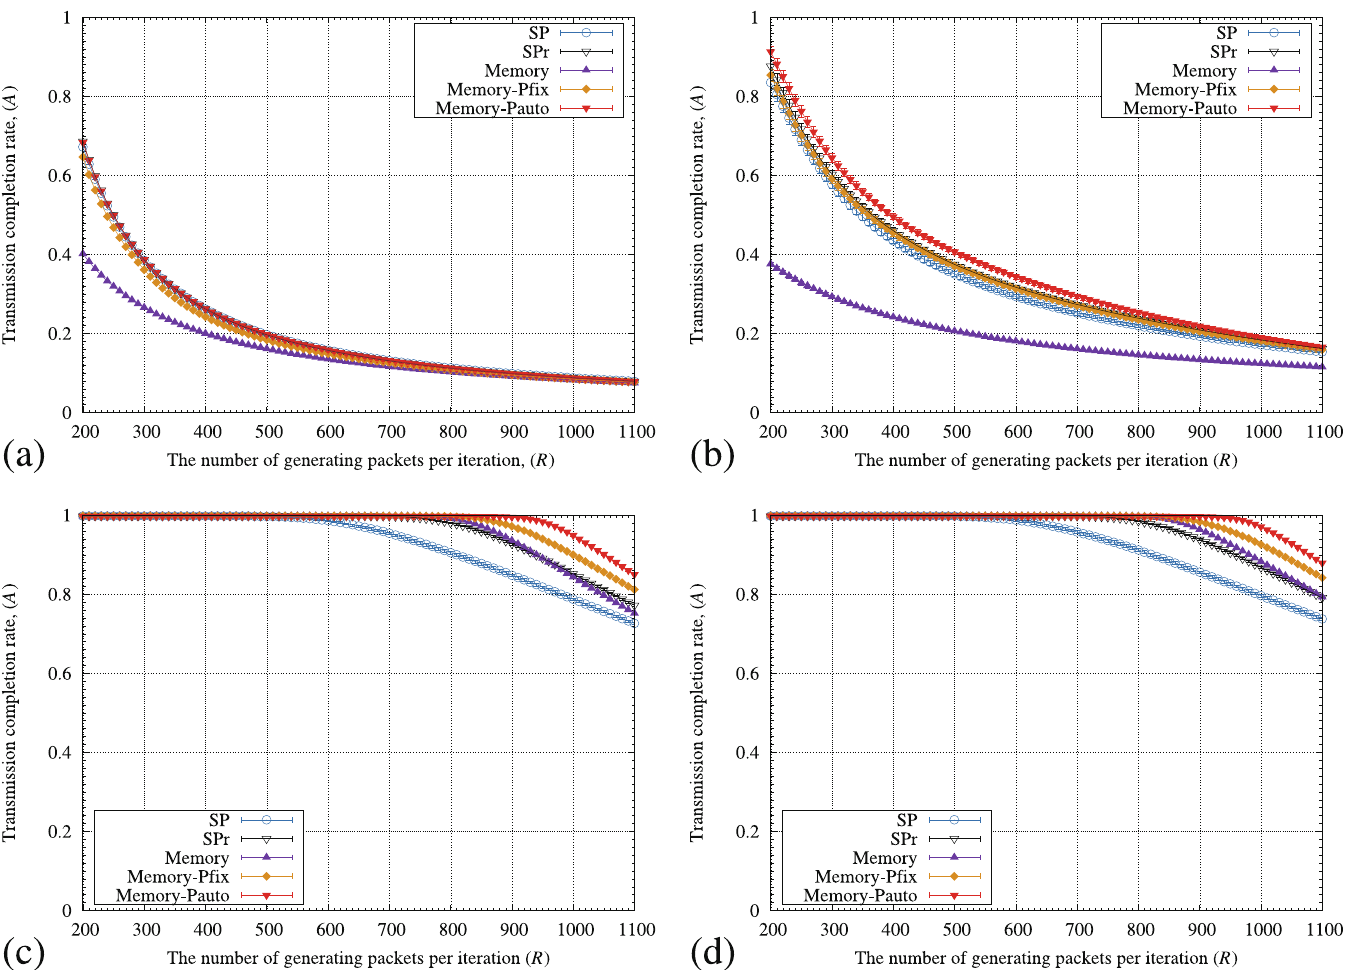
Fig 11. Relationships between the number of generating packets at each iteration ( R ) and the transmission completion rate of arriving packets ( A ) of the SP, SPr, memory-pfix, and memory-pauto methods for the WS model with (a) r method is plotted as error